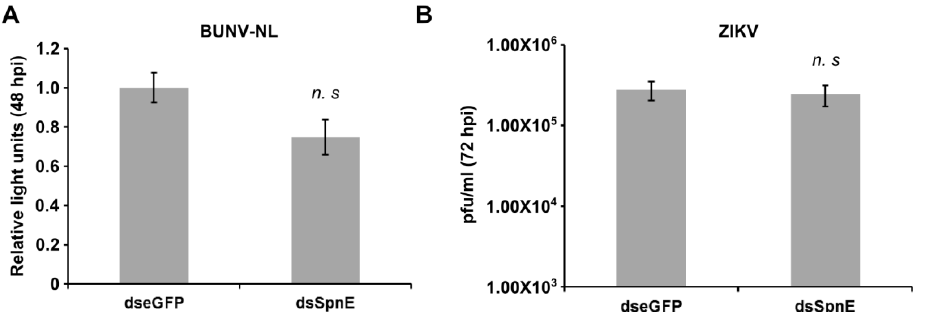
Figure 3. Effect of SpnE silencing on BUNV and ZIKV replication. dsRNAs were transfected into Aag2 cells to silence SpnE and cells treated with eGFP specific dsRNAs were used as control. At 24 hpt cells were infected with either Nanoluc-expressing BUNV-NL or wt ZIKV. ( A ) Cells infected with BUNV-NL (at MOI of 0.01) were lysed at 48 hpi; the relative mean luciferase activity values (normalized to these from dseGFP treated cells), together with the error of the mean from three independent experiments conducted in triplicate, are shown; ( B ) media was harvested at 72 hpi from wild-type ZIKV infected (MOI of 0.1) cells and subjected titration. The mean virus titre together with standard error of 6 independent experiments are shown. “n. s” indicates non-significance according to Student’s t